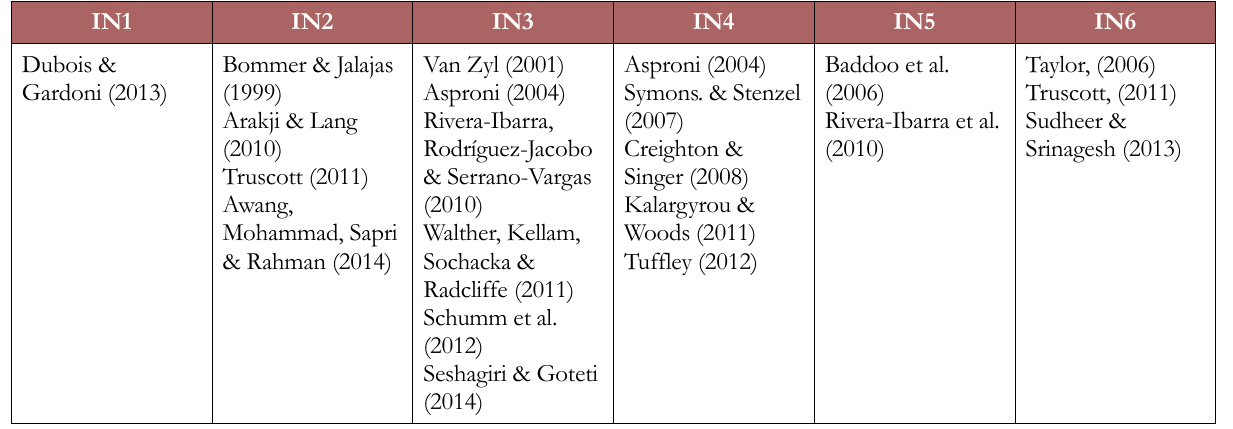
Table 6. FINCODA Initiative supporting